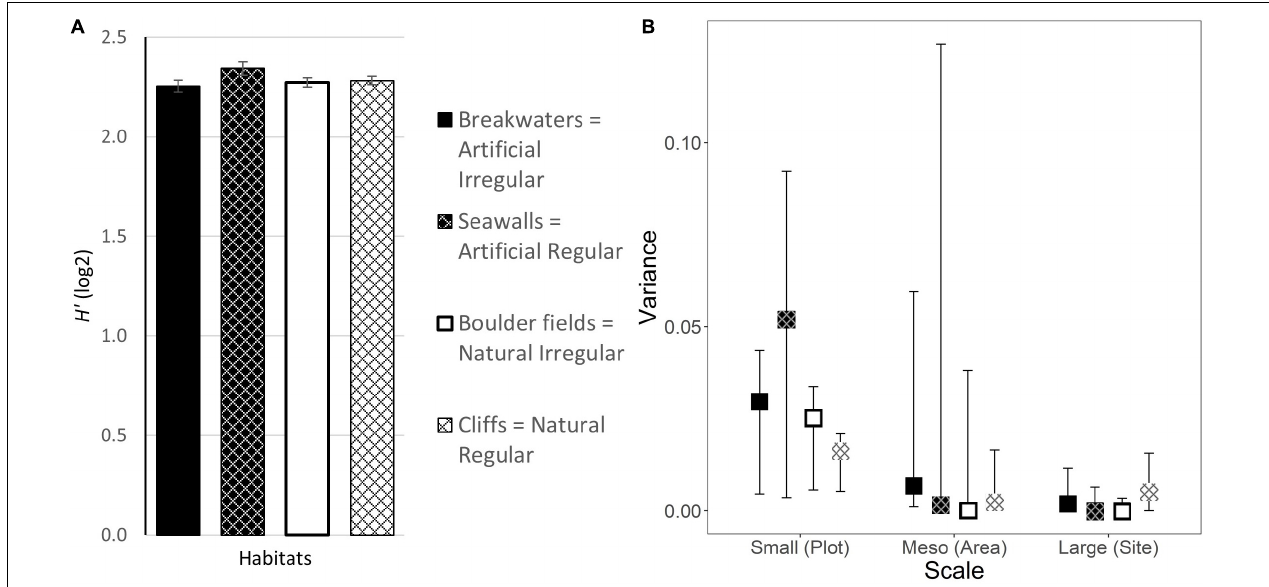
FIGURE 7 | (A) Mean diversity of morphological microelements ( ± 1 SE; data are averages of 2–4 plots at each of 4 areas at each of 3 sites, n = 42–48) and (B) estimated variance in diversity of morphological microelements ( ± 95% CI from bootstrapping) at each scale for the four combinations of habitat Types and Morphologies. Letters indicate significant differences from pairwise-tests ( Supplementary Table 2 ).